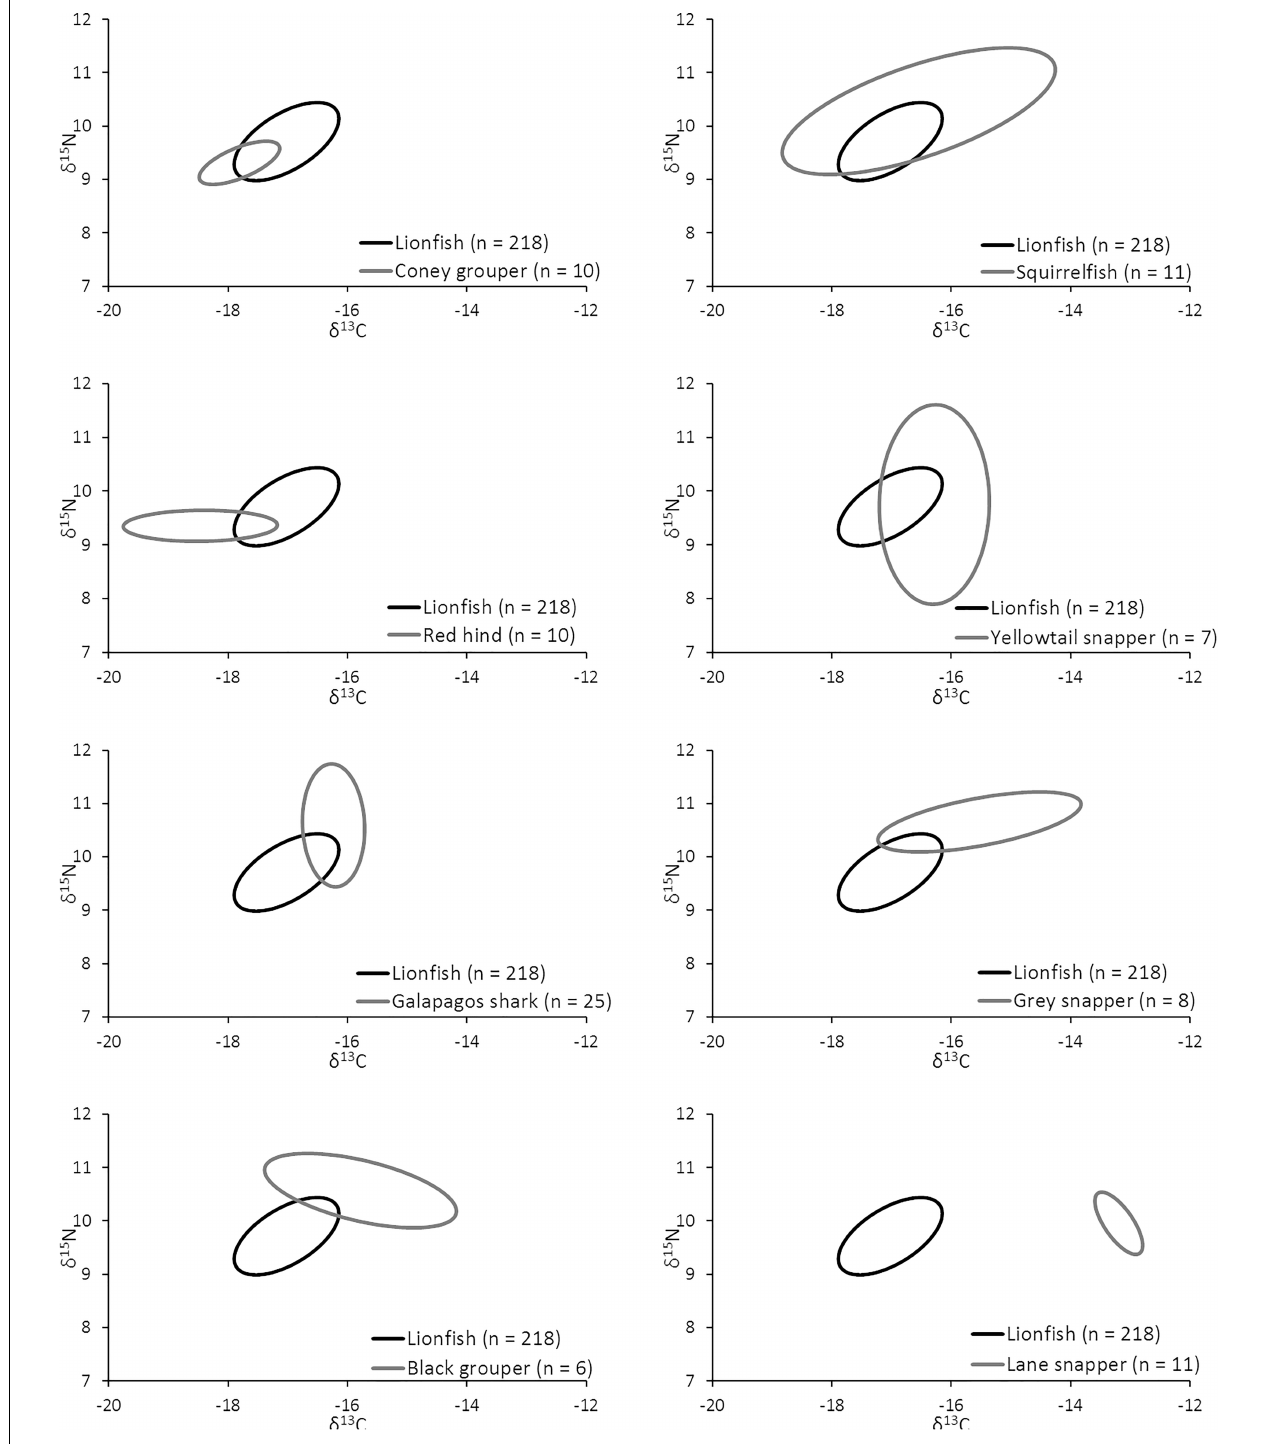
FIGURE 10 | Overlap in isotopic niche potentially indicating a degree of resource overlap (i.e., competition) among eight important predators.